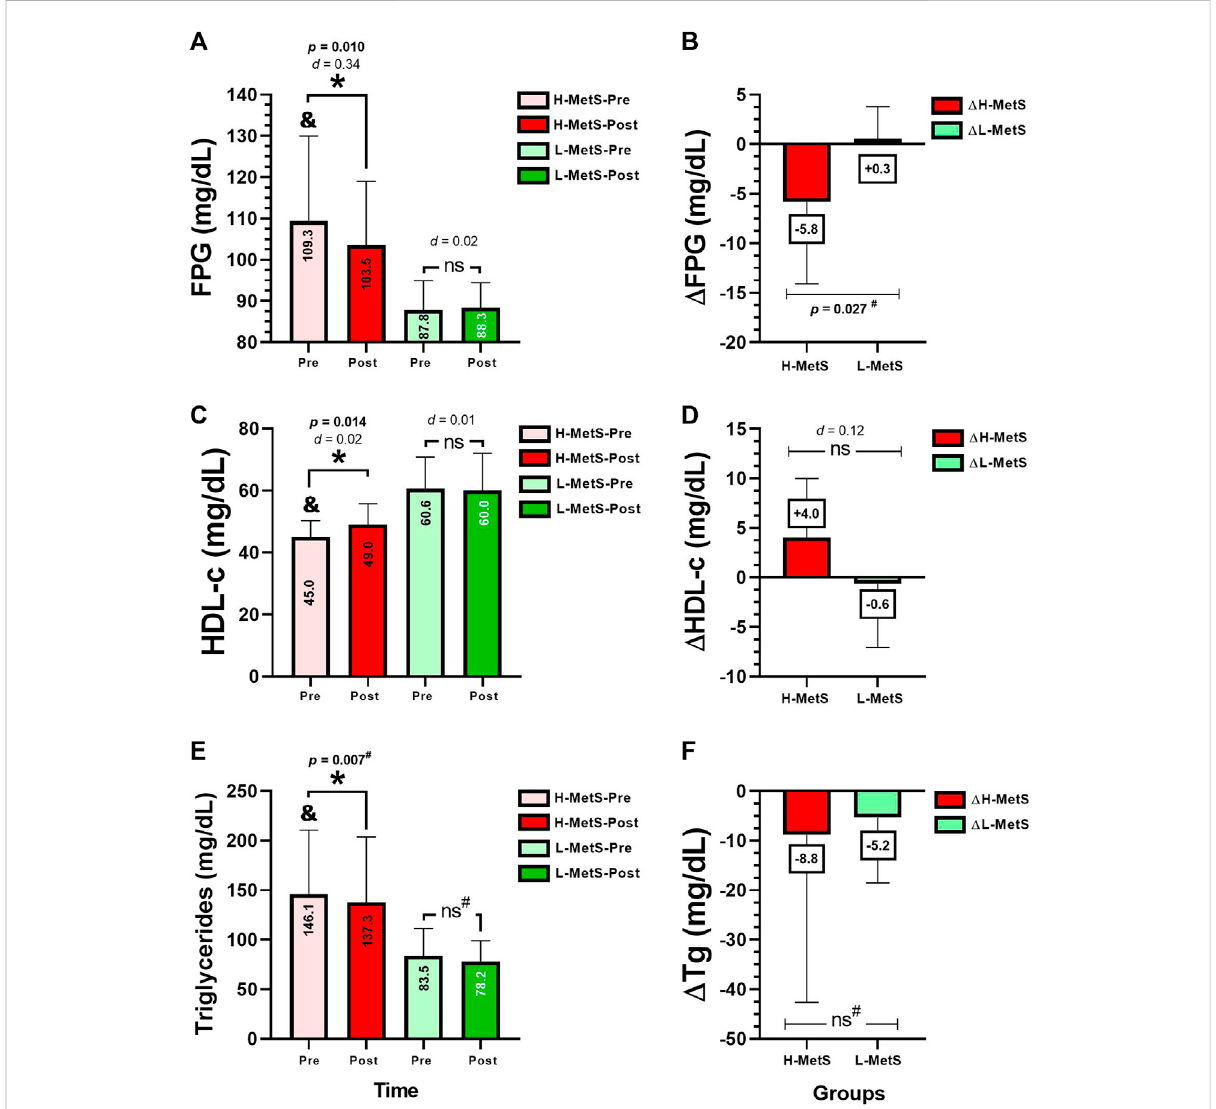
FIGURE 2 Metabolic syndrome outcomes before and after (A,C,E) , and delta changes (B,D,F) between two groups of a different number of risk factors for metabolic syndrome. Groups are described as H-MetS-Pre, high number of metabolic syndrome risk factors group at pre-test; H-MetS-Post, high number of metabolic syndrome risk factors group at post-test; L-MetS-Pre, low number of metabolic syndrome risk factors group at pre-test; L-MetS-Post, low number of metabolic syndrome risk factors group at post-test. Outcomes are described as; FPG, fasting plasma glucose; HDL-c,high-densitylipoproteincholesterol;Tg,triglycerides.(&)Denotessigni fi cantlydifferentversusbaselineL-MetSgroupat p < 0.05.( d )Denotes Cohen d effect size at p < 0.05. (*) denotes signi fi cant differences between the H-MetS vs . L-MetS group at p < 0.05. (ns) denotes no signi fi cant differences between groups. ( # ) Denotes the comparison analyzed by the Mann – Whitney non-parametric